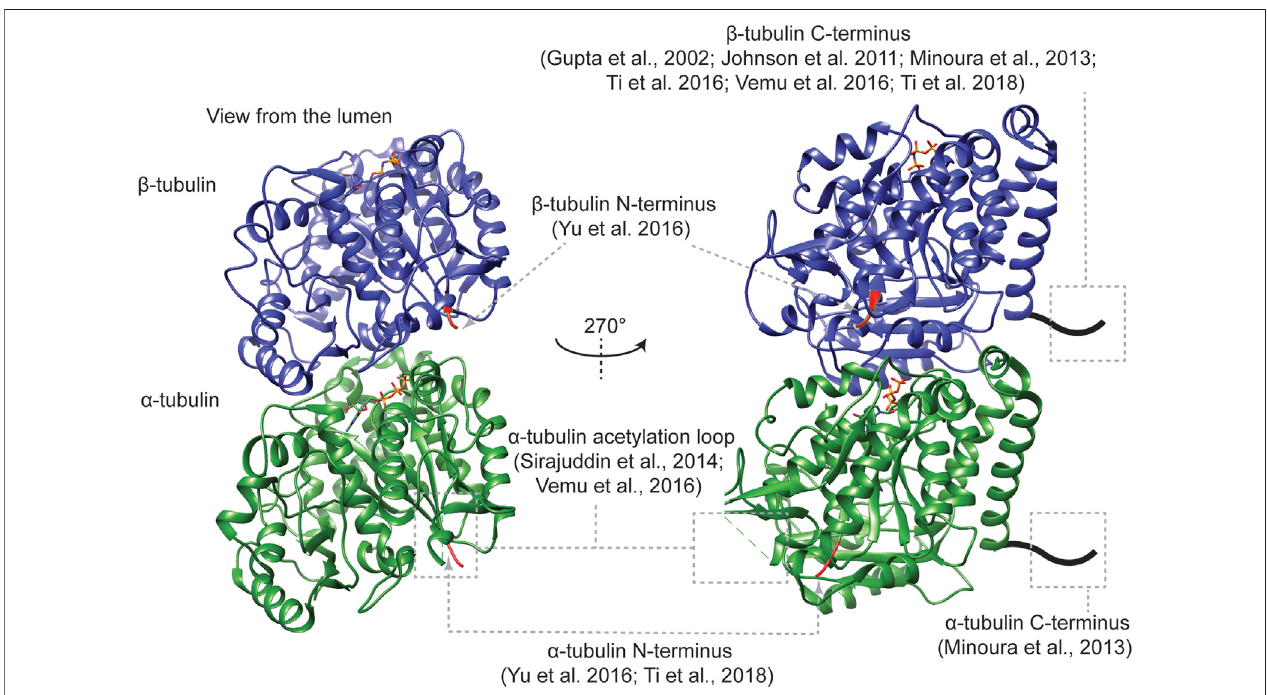
FIGURE 3 | The location of af fi nity tags for the puri fi cation of recombinant tubulin. The ribbon diagrams show the structure of an α / β -tubulin heterodimer (PDB ID: 6e7b). The fi rst three residues at the N-termini of each tubulin are in red, while the rest of α - and β -tubulin are in green and blue, respectively. The stick model represents the tubulin-bound